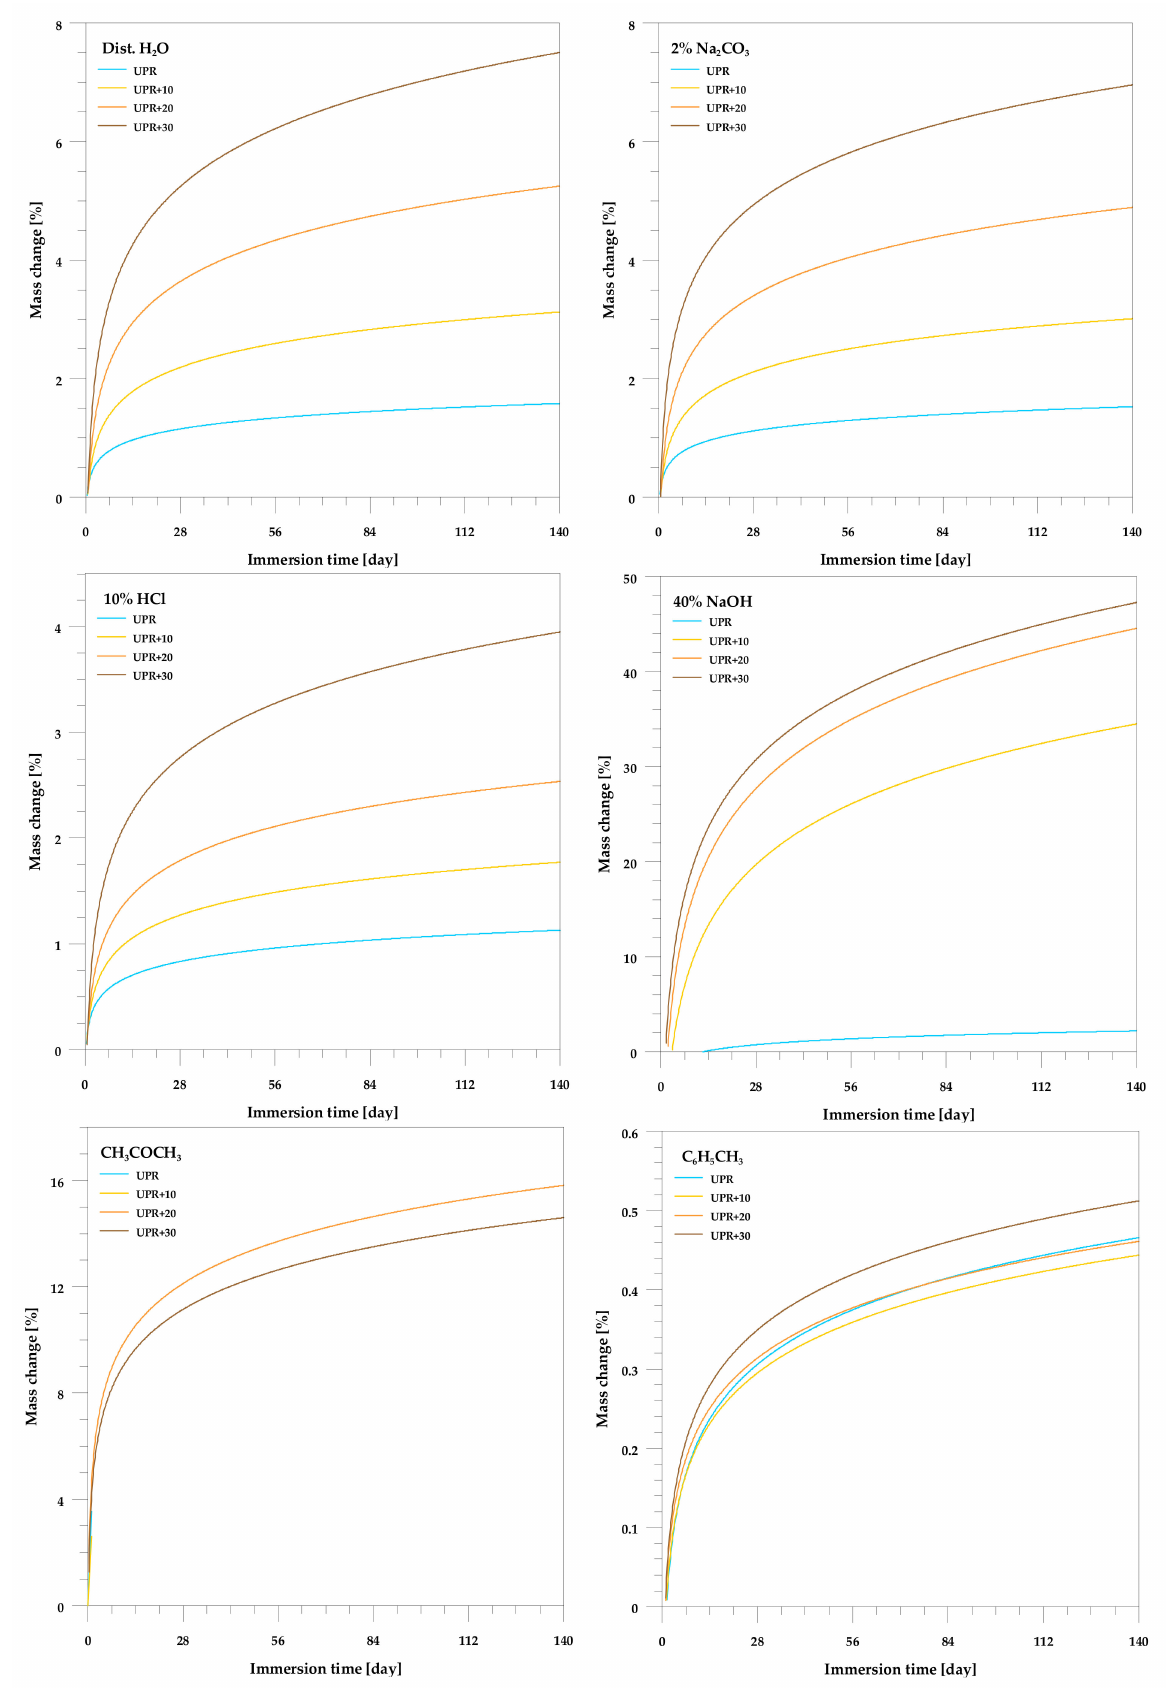
Figure 8. Effect of the chemical resistance of the UPR/PSP